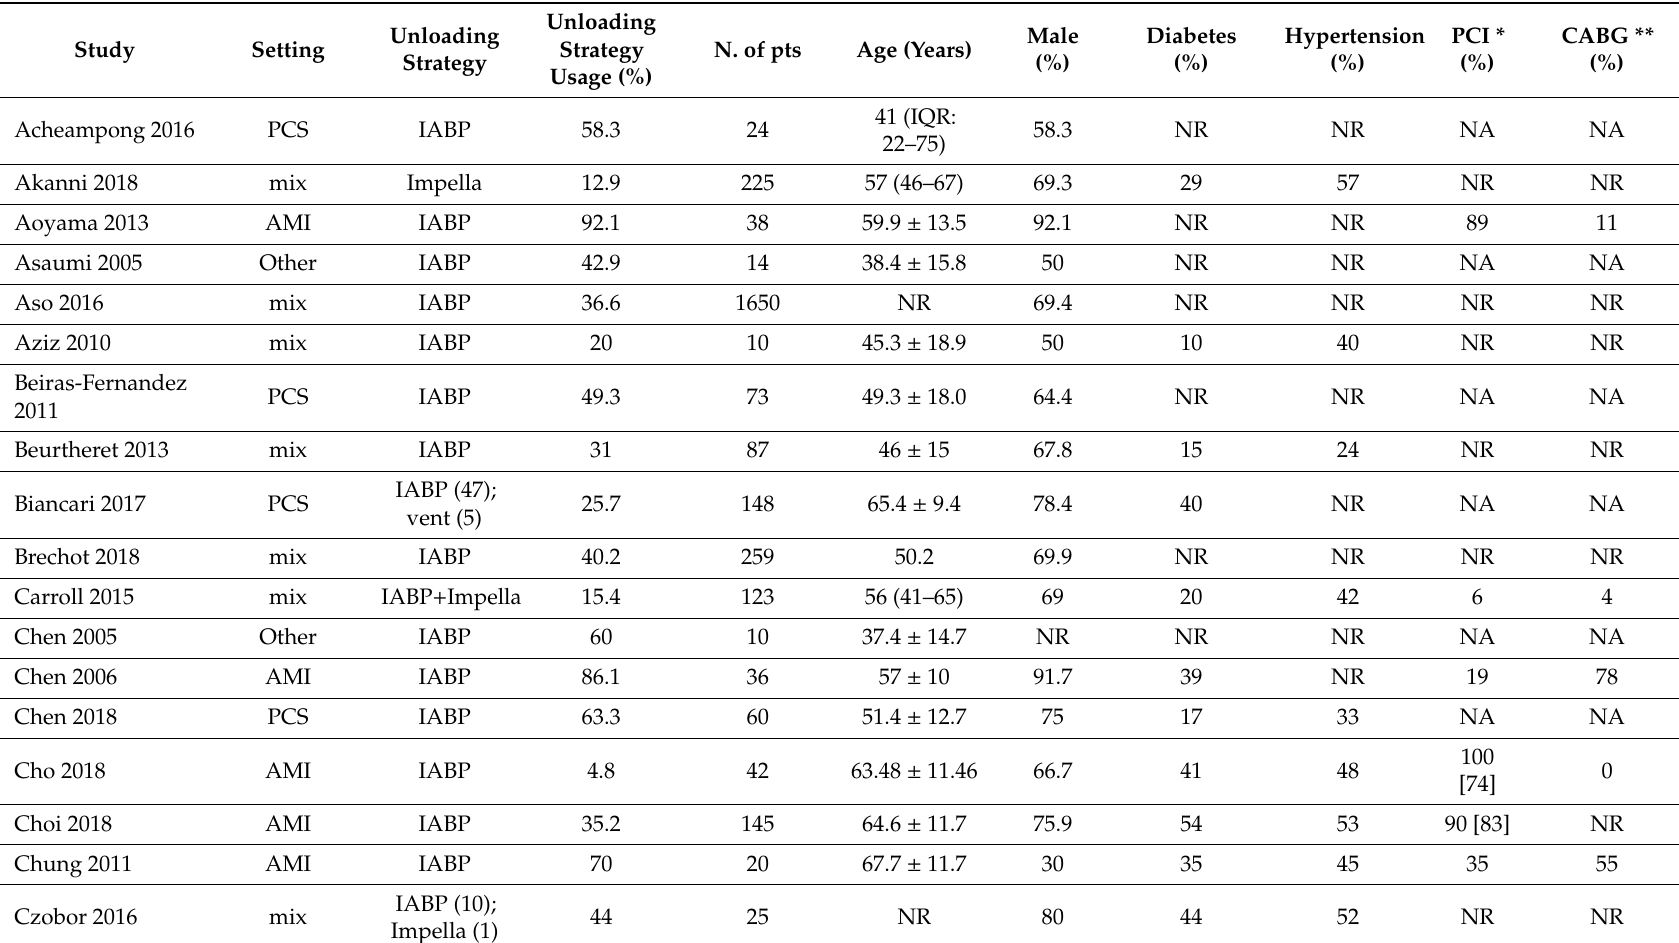
Table A3. Characteristics of